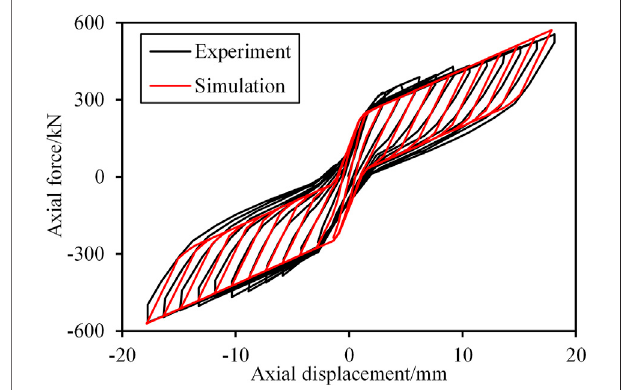
FIGURE 11 | Comparison of SC-BRB experimental and simulation hysteresis